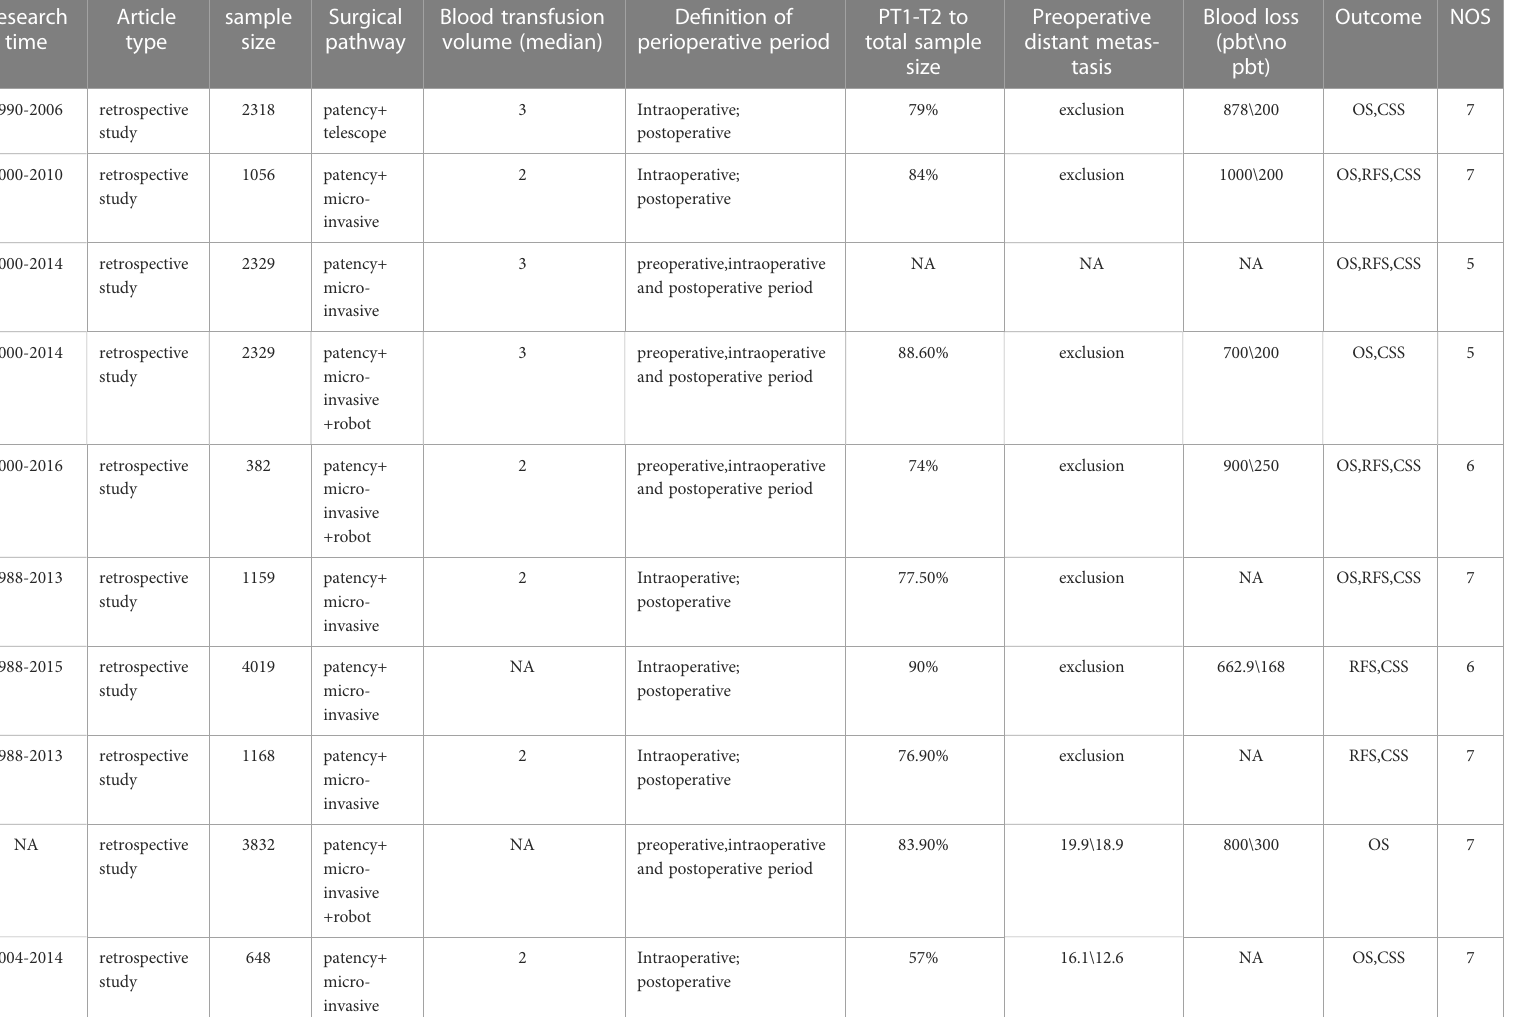
TABLE 1 Table of basic information extracted from the